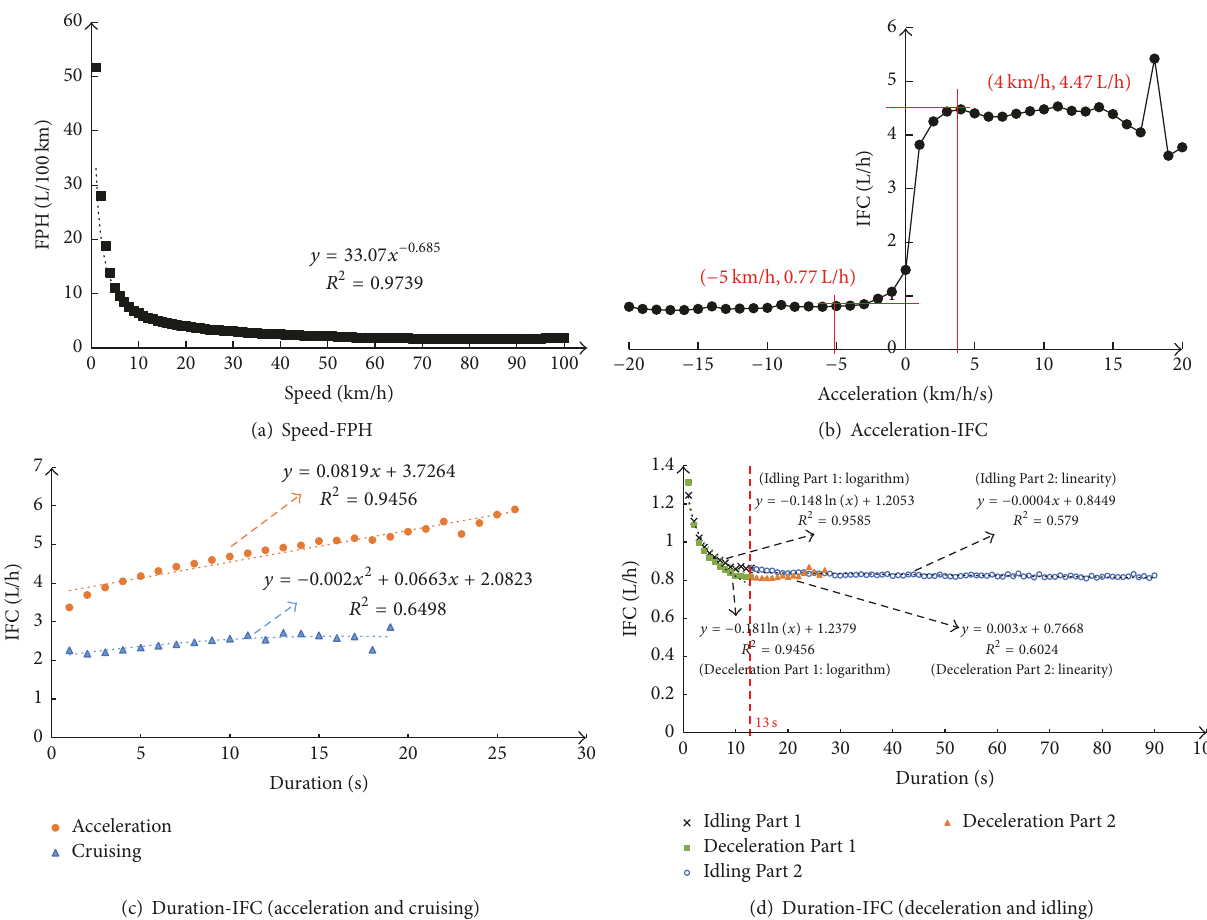
Figure 3: Influence of three parameters on vehicle fuel consumption. Note . Unit of acceleration is km/h/s instead of m/s 2 . The reason is that the values using km/h/s as unit are in accordance with the ones displayed on the dashboard, which are easy to understand for